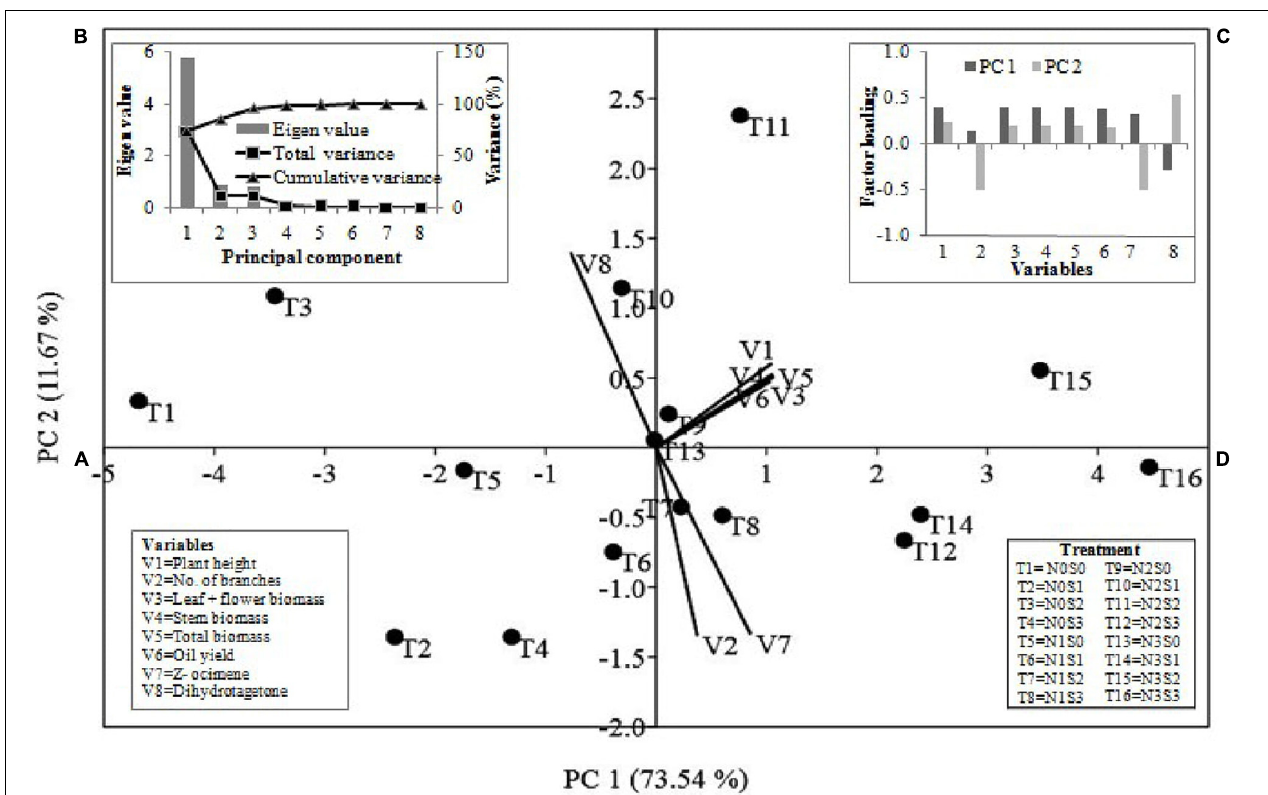
FIGURE 6 | The multivariate analyses of mean value of growth parameters, yield and major compounds of essential oil were conducted through principal component analysis. PC1 and PC2 jointly explained the variations of 85.21% (A–D) . The loading values of variables and treatment combinations (A) are presented as vectors in the space of the PCA. (B,C) presented eigenvalues and loading scores of the variables with PC1 and PC2. N0, N1, N2, and N3 are the level of nitrogen @ 0, 60, 90, and 120 kg ha − 1 , respectively, while S0, S1, S2, and S3 are representing the level of sulfur @ 0, 20, 40, and 60 kg ha − 1 ,